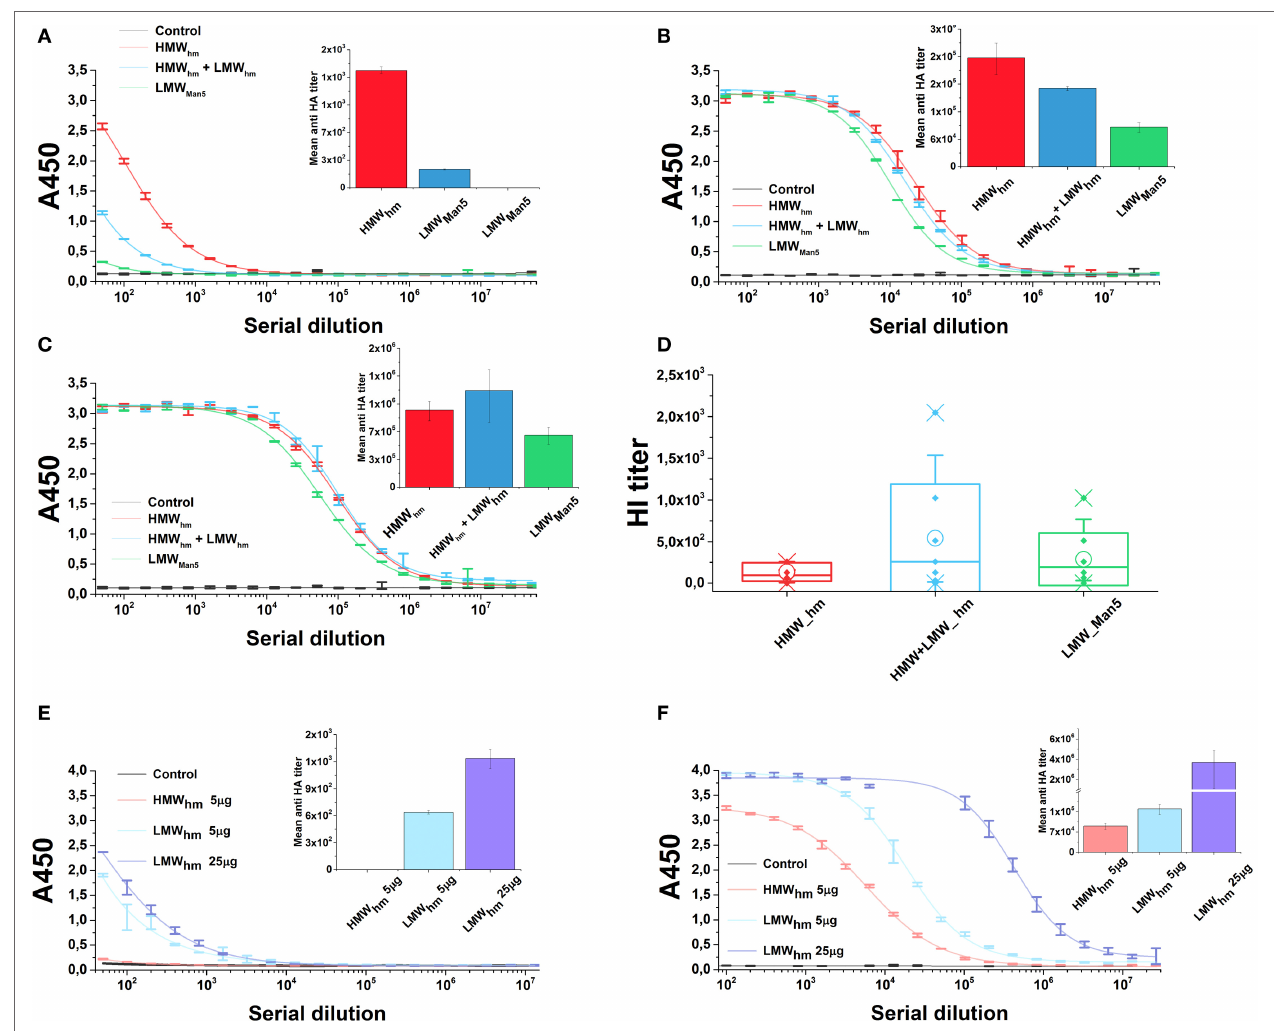
FigUre 7 | humoral response in mice after immunization with the h5 hm and h5 Man5 proteins . Sera samples of mice immunized with 25 µg of H5 hm or H5 Man5 were pooled and the immune responses were measured in duplicate 2 weeks after immunization (a) , booster (B) , and second booster (c) by indirect enzyme-linked immunoabsorbant assay (ELISA) (non-linear fitting plots—bars represent SD, column plots—bars represent 95% confidence level) and 2 weeks after second booster by hemagglutination inhibition (HI) test (D) . Line plots represent fits for each group HI test was performed with homologous H5N1 virus (A/turkey/Poland/35/2007 H5N1, clade 2.2.3). Data for individuals (Raw data, ♦ ), mean ( ○ ), and the medians (—) are shown for each group. During the second immunization experiment, two doses of LMW H5 hm were tested. Sera samples of mice immunized twice with 5 µg of HMW H5 hm , LMW H5 hm , or 25 µg of H5 hm were measured 2 weeks after first antigen injection (e) and booster (F) by indirect ELISA (bars represent 95% confidence